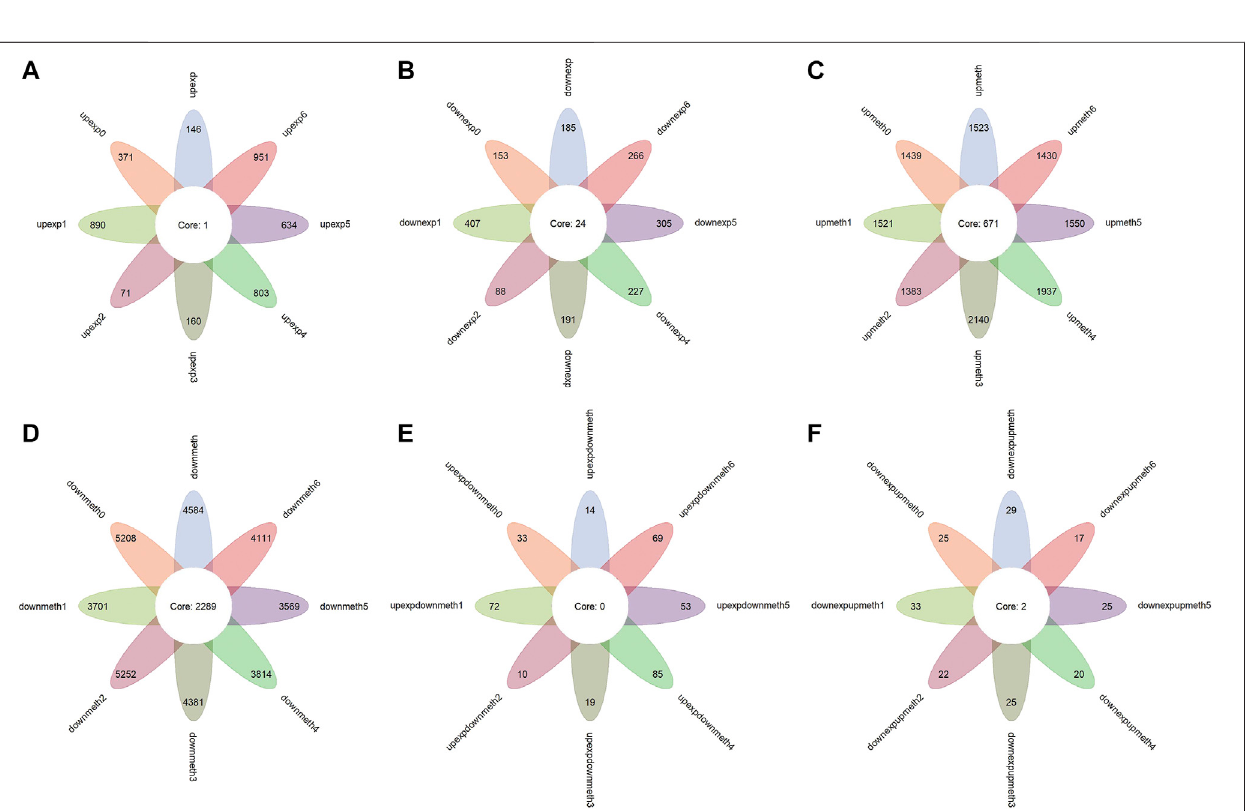
FIGURE 2 | Functional enrichment analysis for dysregulated genes. The color of the point means the signi fi cance ( p -value). The size of the point means the gene number. (A) The biologicalprocess enrichmentofupregulated expressed genes incoloncancer andsubtypes. (B) Thebiological process enrichment ofdownregulated expressedgenesincoloncancerandsubtypes. (C) TheKEGGpathwayenrichmentofdownregulatedexpressedgenesincoloncancerandsubtypes. (D) Thebiological process enrichment ofupregulated methylated genes in colon cancer and subtypes. (E) The biological process enrichment of downregulated methylated genes in colon cancer and subtypes. (F) The KEGG pathway of downregulated methylated genes in colon cancer and subtypes. The biological process enrichment of upregulated expressed and downregulated methylated genes in colon cancer and subtypes. The biological process enrichment of downregulated expressed and upregulated methylated genes in colon cancer and